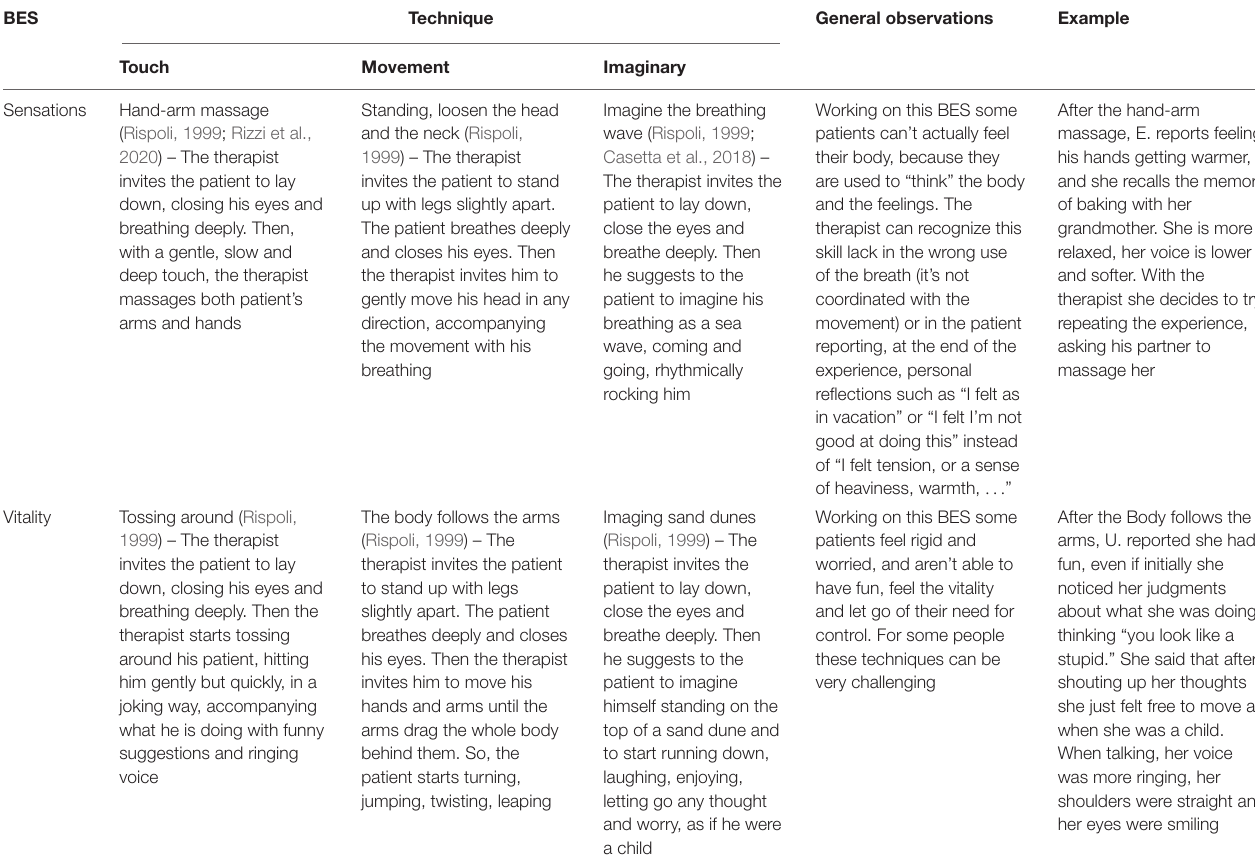
TABLE 2 | Examples of BES, FP techniques, general observations, and clinical extracts from our sample’s therapies.